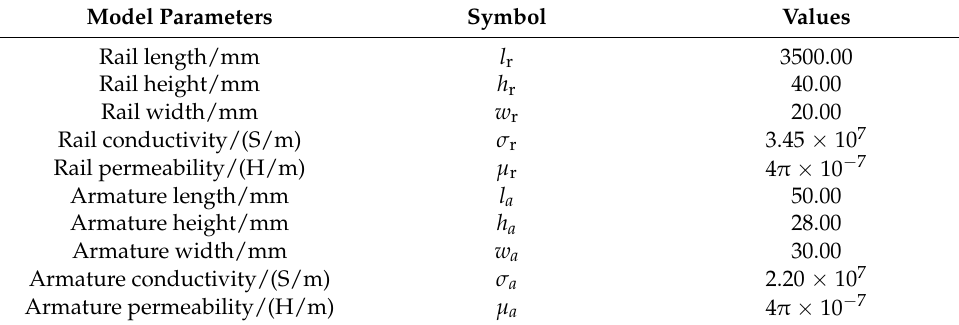
Table 1. Parameters of armature and rail model.